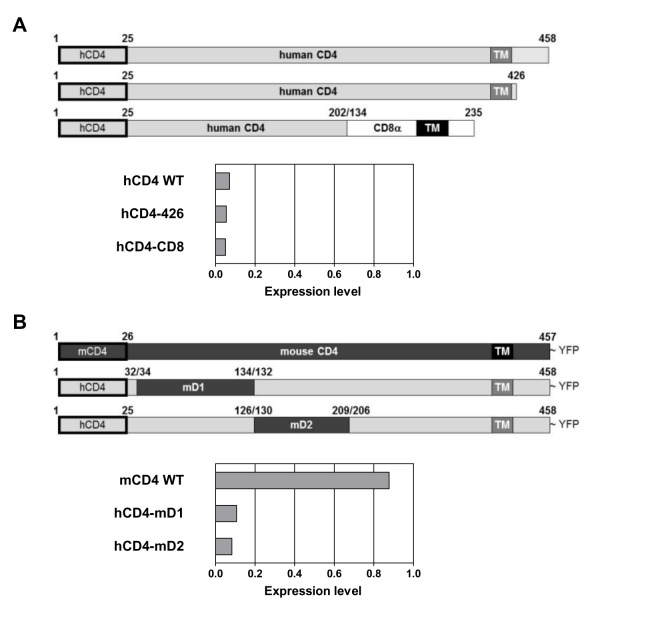
CADA inhibits the expression of human CD4 in a signal peptide-dependent way.(A) Schematic representation of the hCD4 C-terminal deletion constructs used. Numbers represent the corresponding amino acids of the pre-protein. The N-terminal SPs are indicated by a black rectangle. In mutant hCD4-426 the intracellular C-terminal domain has been removed. Construct hCD4-CD8 is composed of the D1 and D2 domains of hCD4 fused to the membrane-bound alpha chain of hCD8. CD4− A2.01 human T-cells stably expressing hCD4WT, hCD4-426, or hCD4-CD8 were treated for 48 h with control medium or CADA (8 µM) and stained with anti-CD4 antibody to determine surface expression levels of WT or mutant CD4 by flow cytometry. Graph shows relative receptor expression levels of CADA-treated cells as compared to non-treated controls. (B) Schematic representation of the human/mouse chimaeric constructs used. Numbers represent the corresponding amino acids of the pre-protein. The N-terminal SPs are indicated by a black rectangle. The human/mouse chimaeric constructs are C-terminally fused to YFP for ease of flow cytometric detection. Construct hCD4-mD1 is composed of hCD4 in which the D1 region is replaced by the corresponding D1 domain of mouse CD4. It still contains the SP of hCD4 and the first seven residues of mature hCD4. Construct hCD4-mD2 is composed of hCD4 in which the D2 is replaced by the corresponding D2 domain of mouse CD4. HEK293T cells were transiently transfected with the expression plasmids and left either untreated or treated with CADA for 24 h. YFP fluorescence was determined and normalized to non-treated controls.